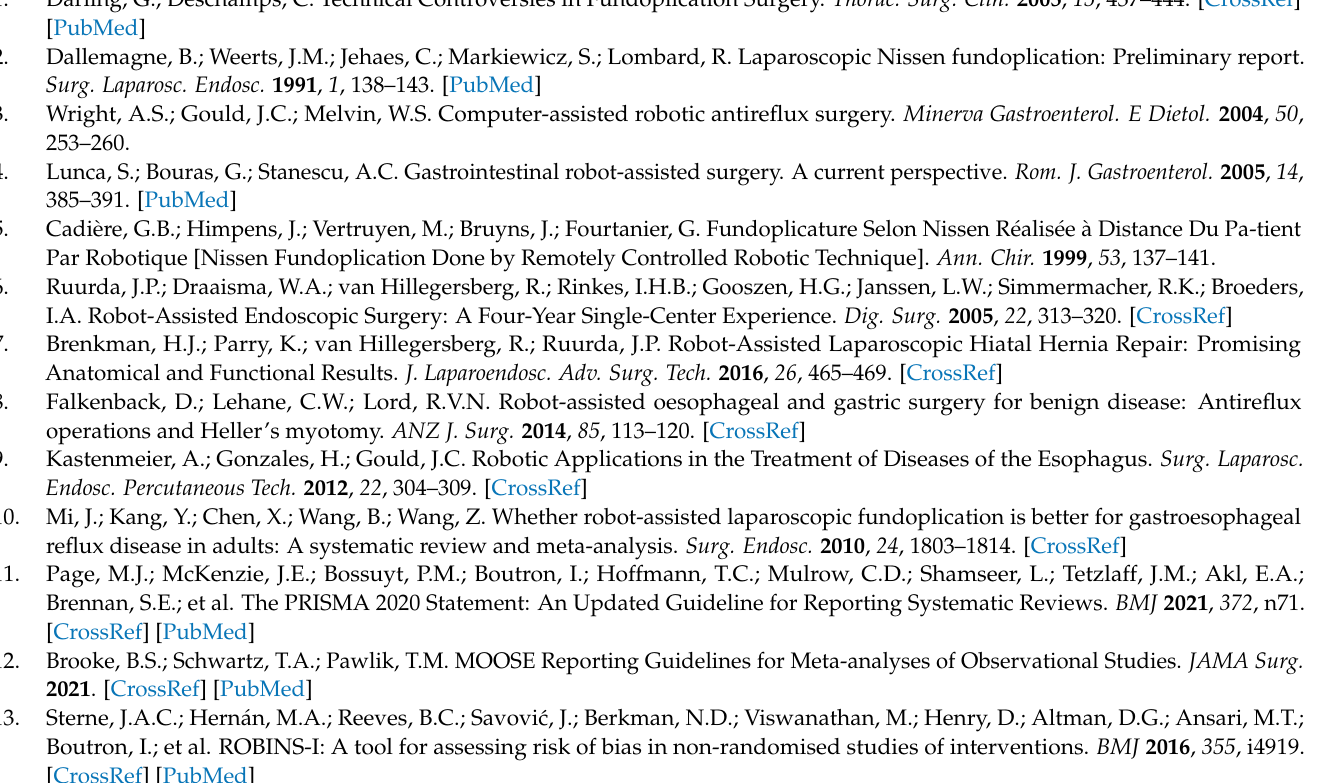
rates; Figure S5: Funnel plot of recurrence of reflux symptoms; Figure S6: Funnel plot of reoperation; Figure S7: Funnel plot of persistence of